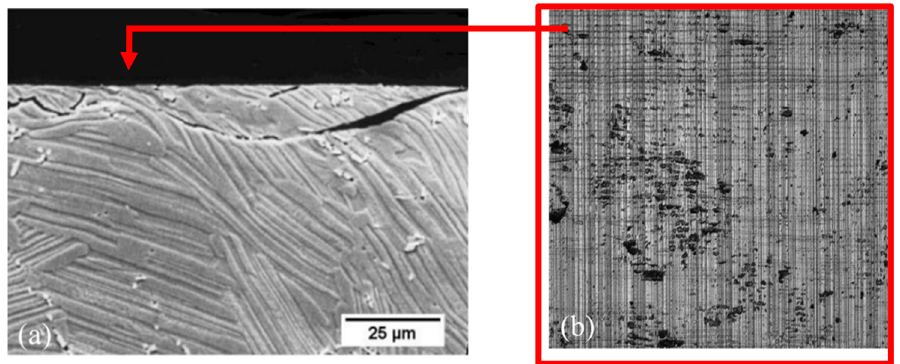
Figure 5. Surface cracks observed ( a ) during turning of Ti-45Al-2Nb-2Mn-0.8 vol% TiB2 [22] and ( b ) at a 21 µm chip thickness and 60 m/min, with the authors’ experimental setup (top view).